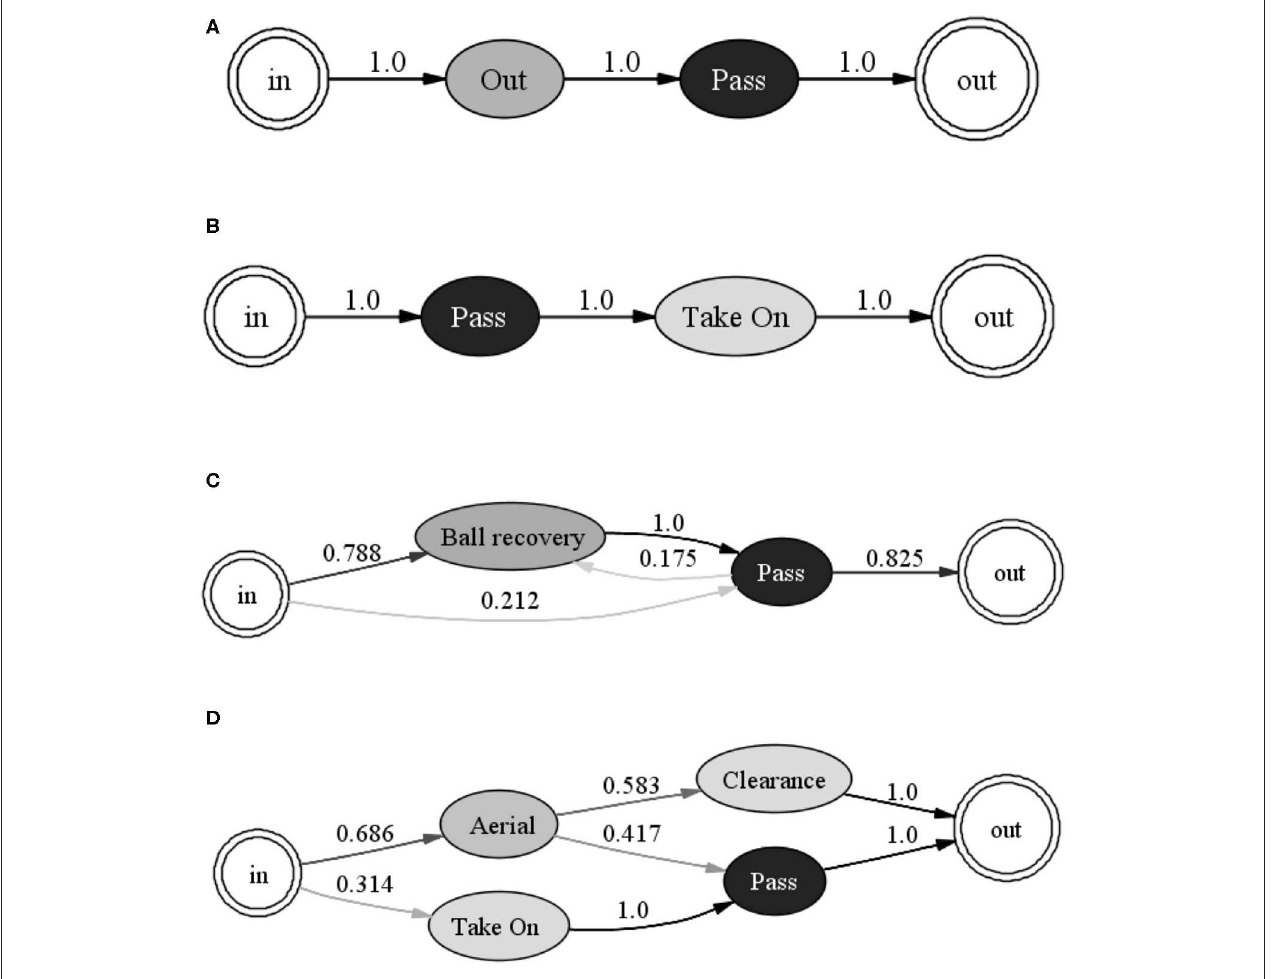
FIGURE 7 | Markov chains for England’s team. (A) Cluster 0: 30 instances, (B) Cluster 1: 3 instances, (C) Cluster 2: 33 instances, (D) Cluster 3: 35